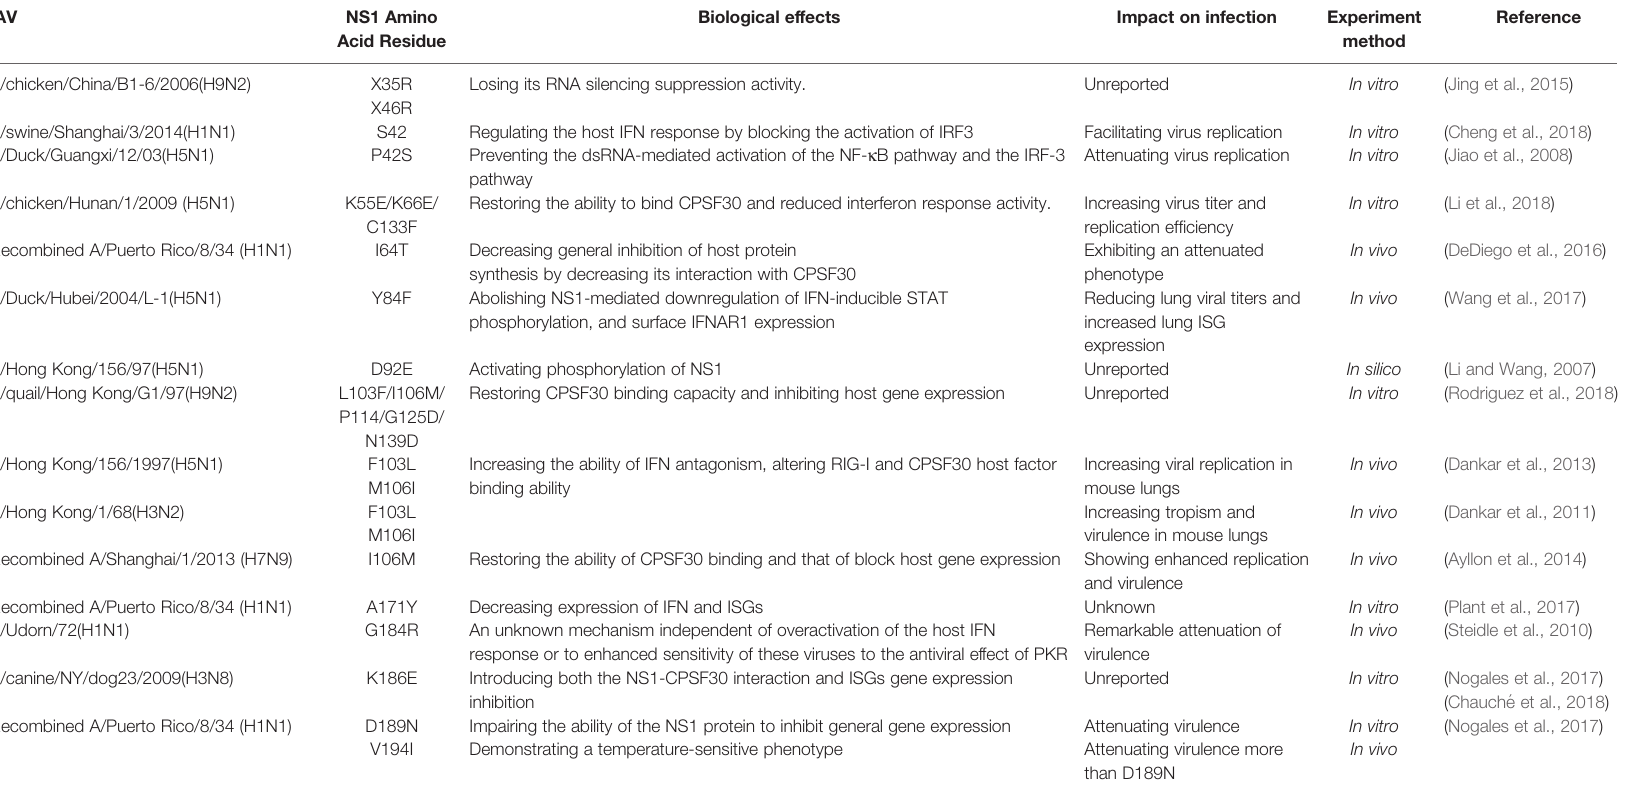
TABLE 1 | Effects of changes of amino acid sites in NS1 on biological